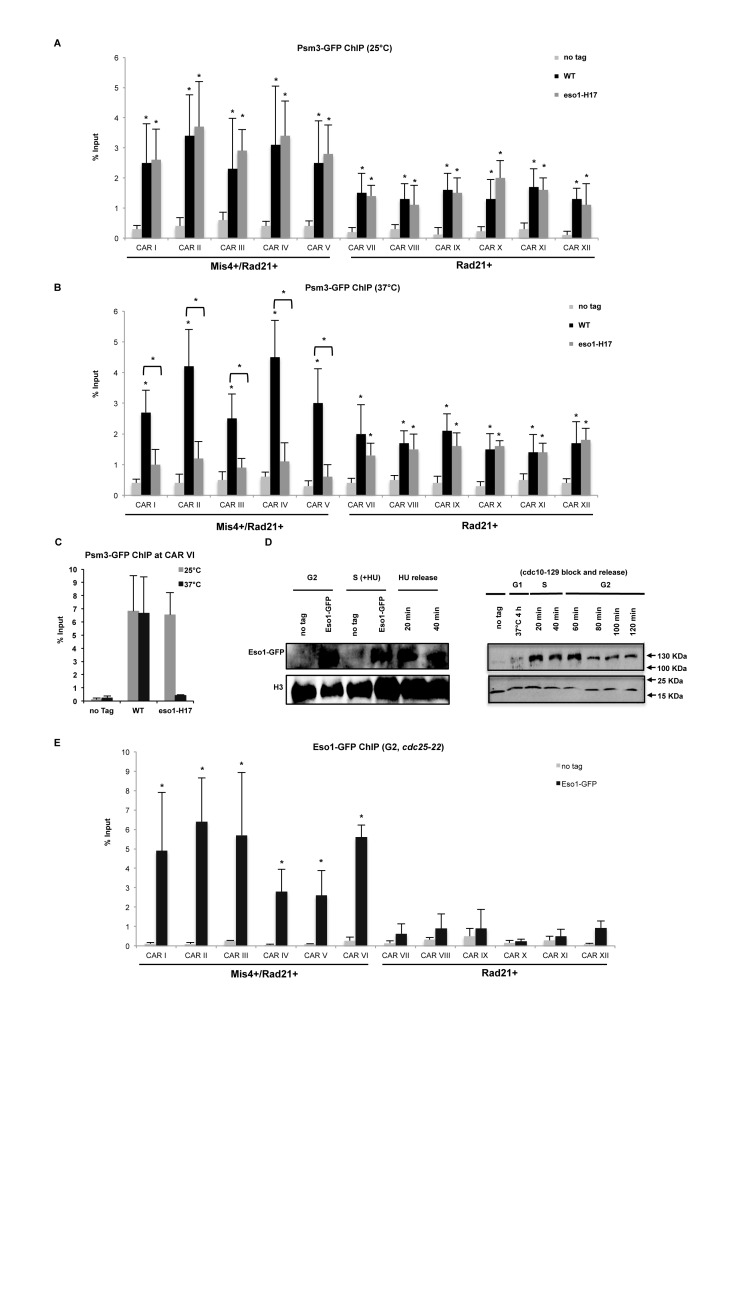
Cohesin at Mis4+/Rad21+ loci is stabilized by Eso1. (A) ChIP-qPCR analysis showing Psm3-GFP enrichment at selected CARs in WT and eso1-H17 cells at 25°C. No tag strain was used to assess the background levels. *P < 0.05, two-tailed, paired Student's t-test for Psm3-GFP compared to background levels. Error bars represent SD, n = 3. (B) ChIP-qPCR analysis showing Psm3-GFP enrichment at selected CARs in WT and eso1-H17 cells at 37°C. No tag strain was used to assess the background levels. *P < 0.05, two-tailed, paired Student's t-test for Psm3-GFP compared to background levels. Error bars represent SD, n = 3. (C) ChIP-qPCR analysis showing Psm3-GFP enrichment at centromeric dg repeat (CAR VI) in WT and eso1-H17 cells at 25 and 37°C. Error bars represent SD, n = 3. (D) Left panel: western blot showing Eso1-GFP protein levels in G2/S phase cells. Whole cell extracts were prepared from cycling cells (G2), cells arrested in early S-phase with Hydroxyurea (HU) and subsequently released into G2 at indicated time points. No tag is a control for anti-GFP antibody specificity and Histone H3 is used as a loading control. Right panel: western blot showing Eso1-GFP protein levels in G1 synchronized cells through to G2 at respective time points. H3 is used as a control. (E) ChIP-qPCR analysis showing Eso1-GFP enrichment at selected CARs in G2 synchronized cells (cdc25-22, 37°C, 4 h). No tag strain was used to assess the background levels. * P < 0.05, two-tailed, paired Student's t-test for Eso1-GFP compared to background levels. Error bars represent SD, n = 3.